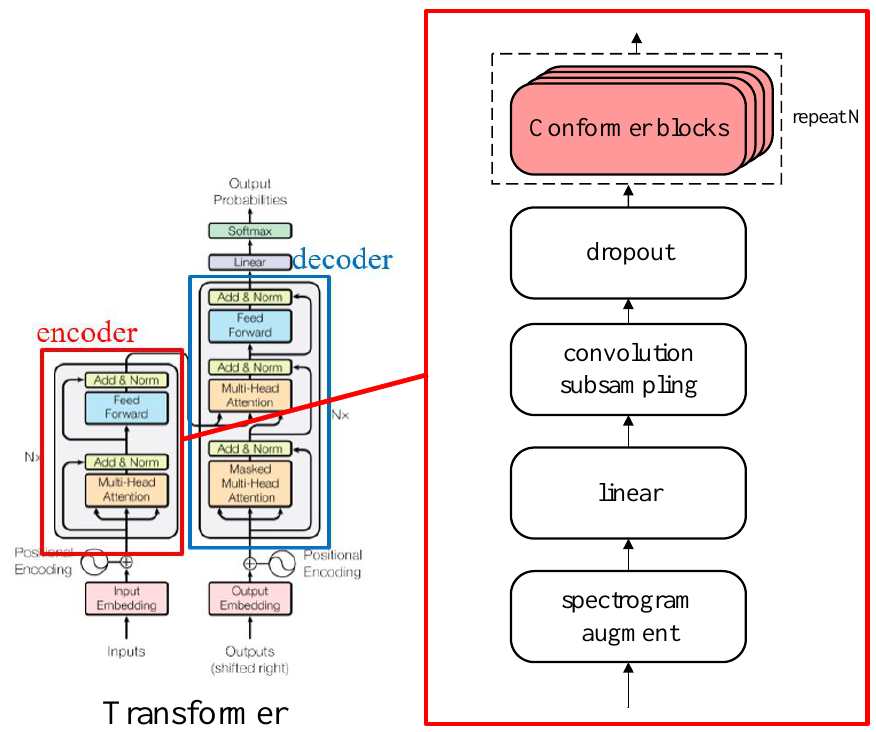
Figure 6. Conformer model structure.